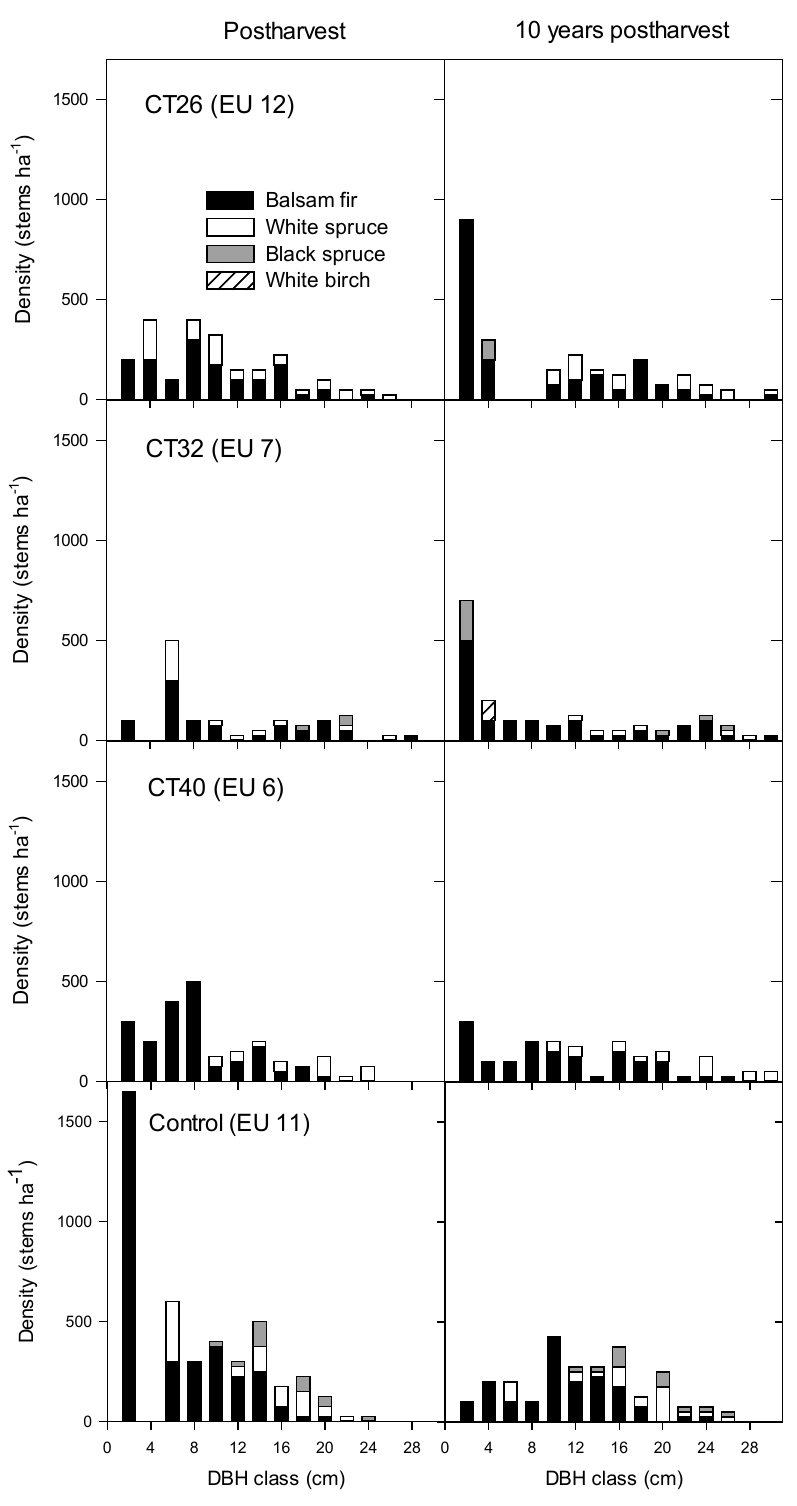
Figure 5. Diameter distribution (2-cm classes) of selected experimental units (EUs) in each commercial thinning treatment: 26% (EU 12), 32% (EU 7) and 40% (EU 6) merchantable basal area removals and an unthinned control (EU 11). Distributions are presented immediately postharvest and 10 years after thinning. Distributions for the remaining EUs can be found online as Supplementary